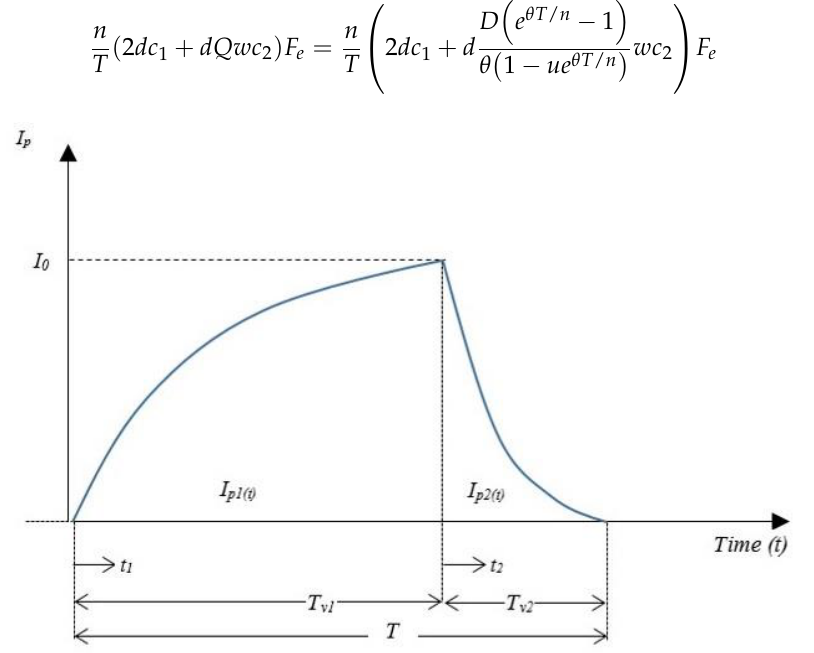
Figure 6. I p1 ( t 1 ) and I p2 ( t 2 ) vs. time.